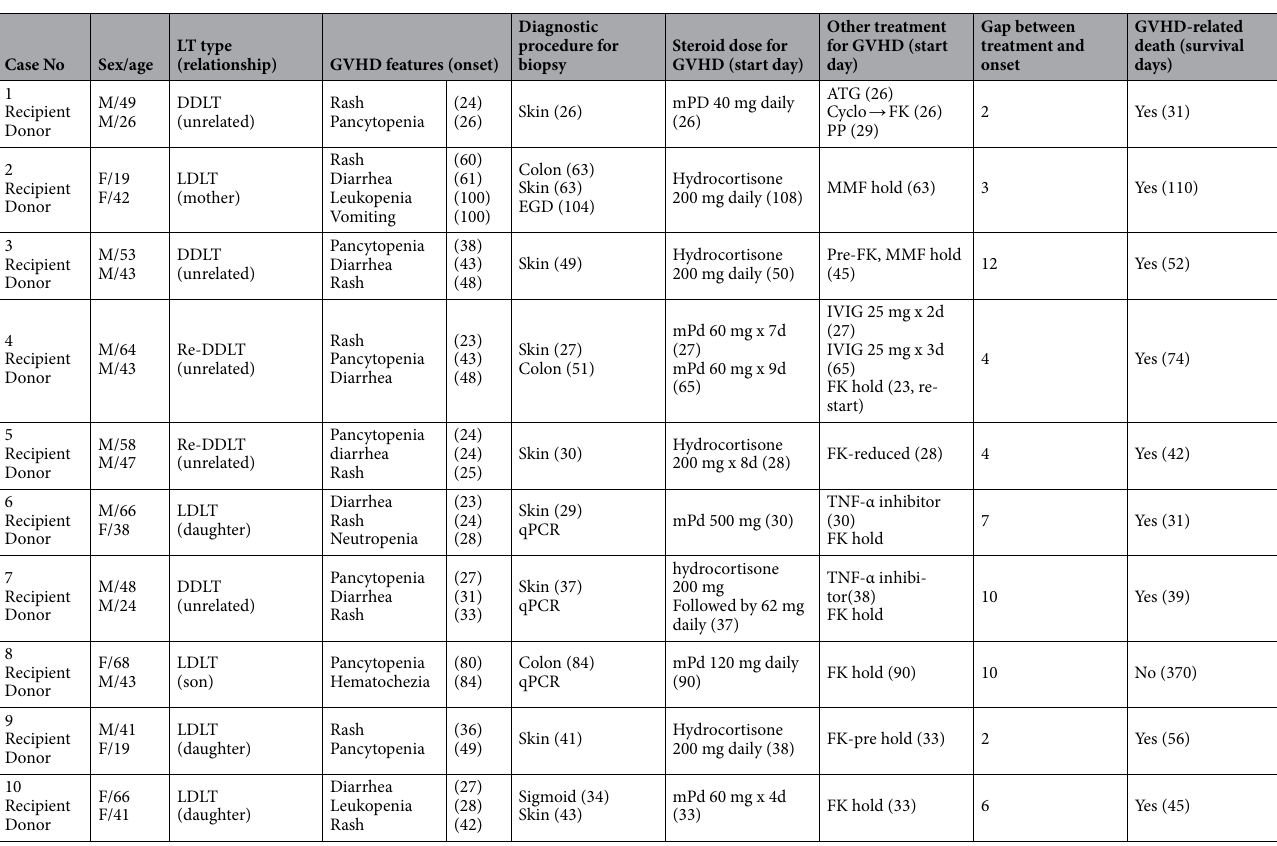
Table 6. Clinical presentation and treatment of each patient with GVHD. GVHD, graft versus host disease; LT, liver transplantation; R, recipient; D, donor; DM, diabetes mellitus; M, male; F, female; LDLT, living donor liver transplantation; DDLT, deceased donor liver transplantation; TNF, tumor necrosis factor; mPd, methylprednisolone; d,